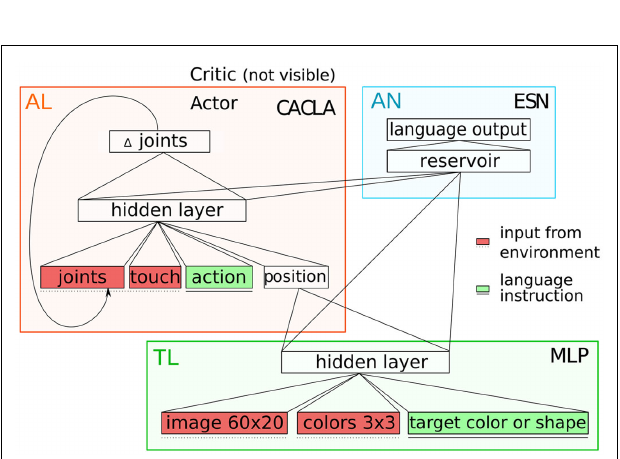
FIGURE 1 | Example of a scene with the simulated iCub acting on objects.